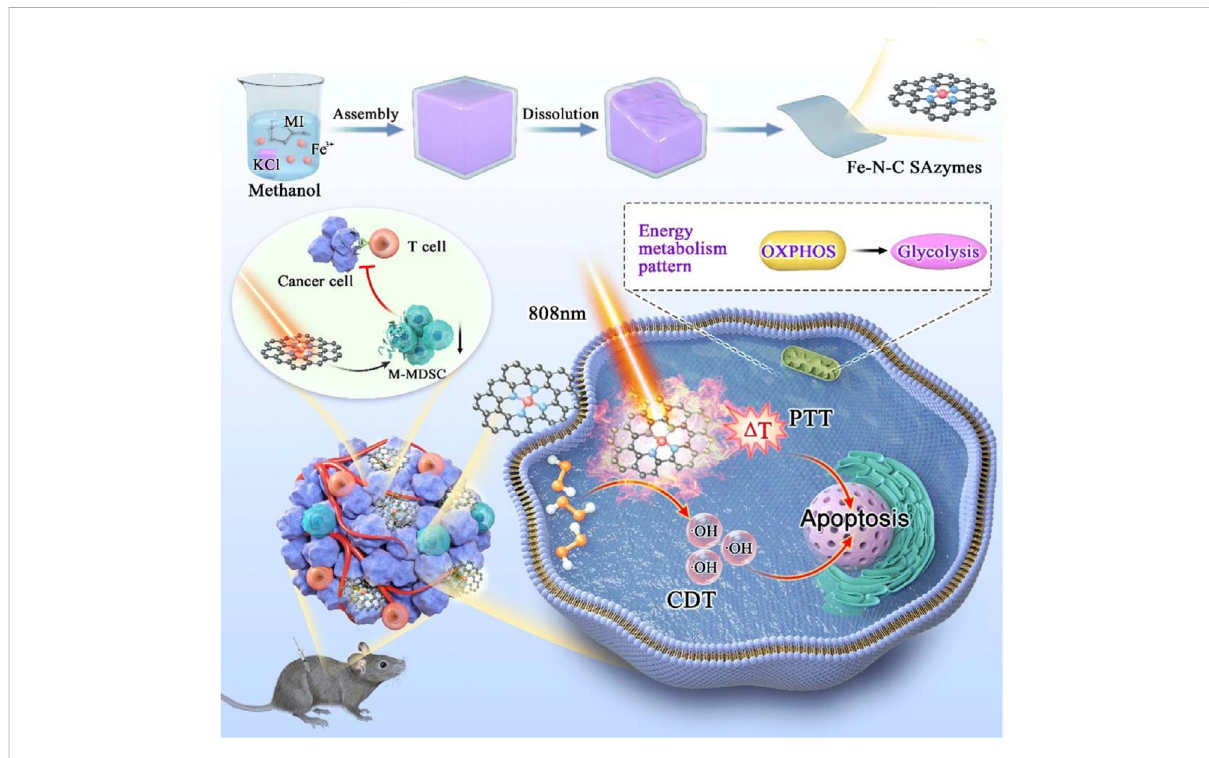
FIGURE 1 Schematic illustration of synthesis process of Fe-N-C SAzymes and the mechanism of cytotoxicity anticancer effect by remodeling energy metabolism and tumor immune landscape for synergistic CDT/PTT therapy.